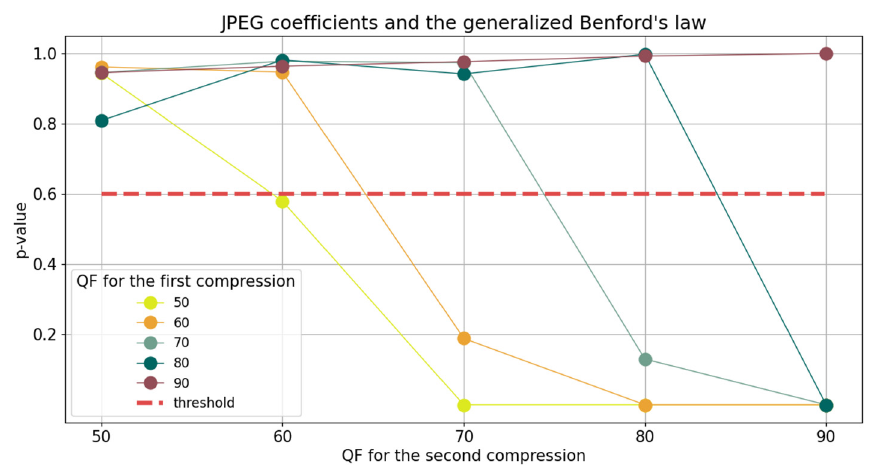
Figure 17. The JPEG coefficients compared to the GBL, using the B channel.